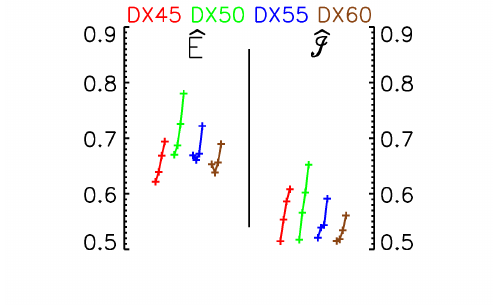
Figure 10. Time-integrated normalised total extinction ˆ E and total ice mass ˆ I for formation flight geometries with different lateral offset DX (ranging between 45m and 60m, see colour legend on top). Similar to Figure 8, each curve connects four symbols that depict the values for lifetimes t int = 2h,4h,6h and